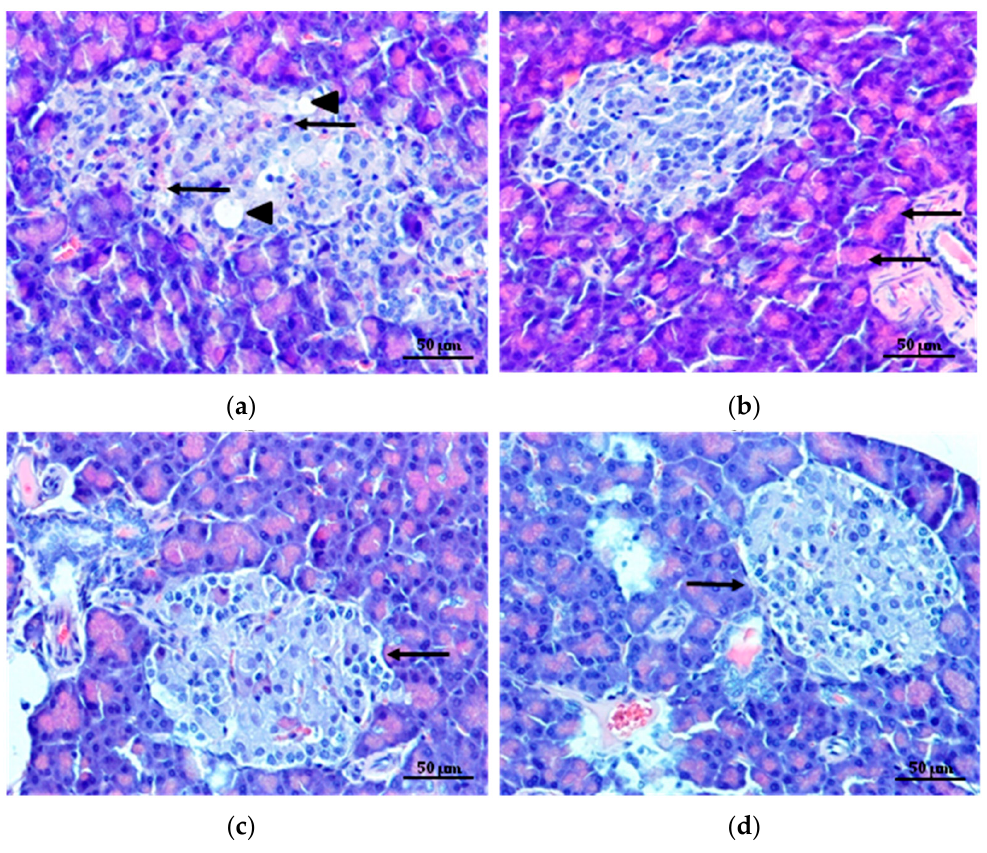
Figrue 7 Figure 7. Representative hematoxylin and eosin stained paraffin pancreas section of diabetic rats ( a ) shows in the endocrine part the islets tended to be enlarged and irregular in shape. Throughout the island, large amount of eosinophilic cells (arrows) and fat droplets (arrowheads) are seen. Pancreas of diabetic rats treated with MF ( b ) depicts islet of Langerhans with a regular shape, surrounded by strongly stained acinar cells. The distant (from the lumen) parts of the glandular cells show basophilic granules and they are stained more deeply than the inner parts (arrows). Pancreas of diabetic rats treated with non cross-linked microparticles formulation C ( c ) depicts normal organ structure with significant reduction of necrosis and degeneration (arrow). Pancreas of diabetic rats treated with cross-linked microparticles formulation CH1M ( d ) shows improvement of irregular shape of Langerhans islets with reduction of degenerative changes (arrow). Magnification ×